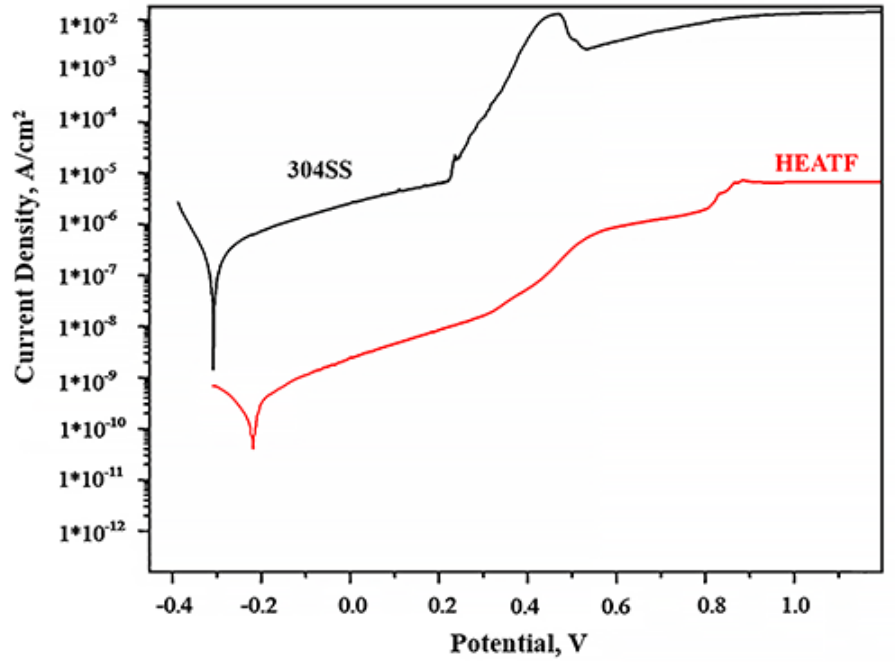
Figure 3. ( a , b ) BSE image and its EDX spectrum displaying a single phase of FeMnNiAlC 10 HEATF, ( c ) is the film XRD pattern.